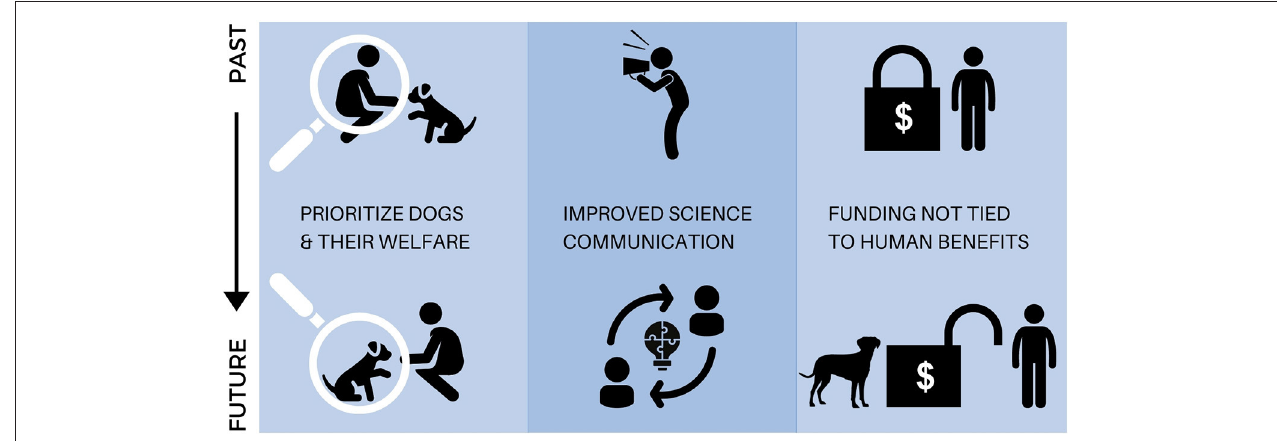
FIGURE 2 | Visual summary of the key issues identified in this Perspective . A sustainable future in canine science will require (1) research approaches that prioritize and monitor the welfare of dogs, (2) improved science communication to avoid incorrect reporting of study results, and to translate research findings to meaningful change in practices relating to dogs, and (3) availability of research funding that is not tied exclusively to studying the possible benefits of dogs for